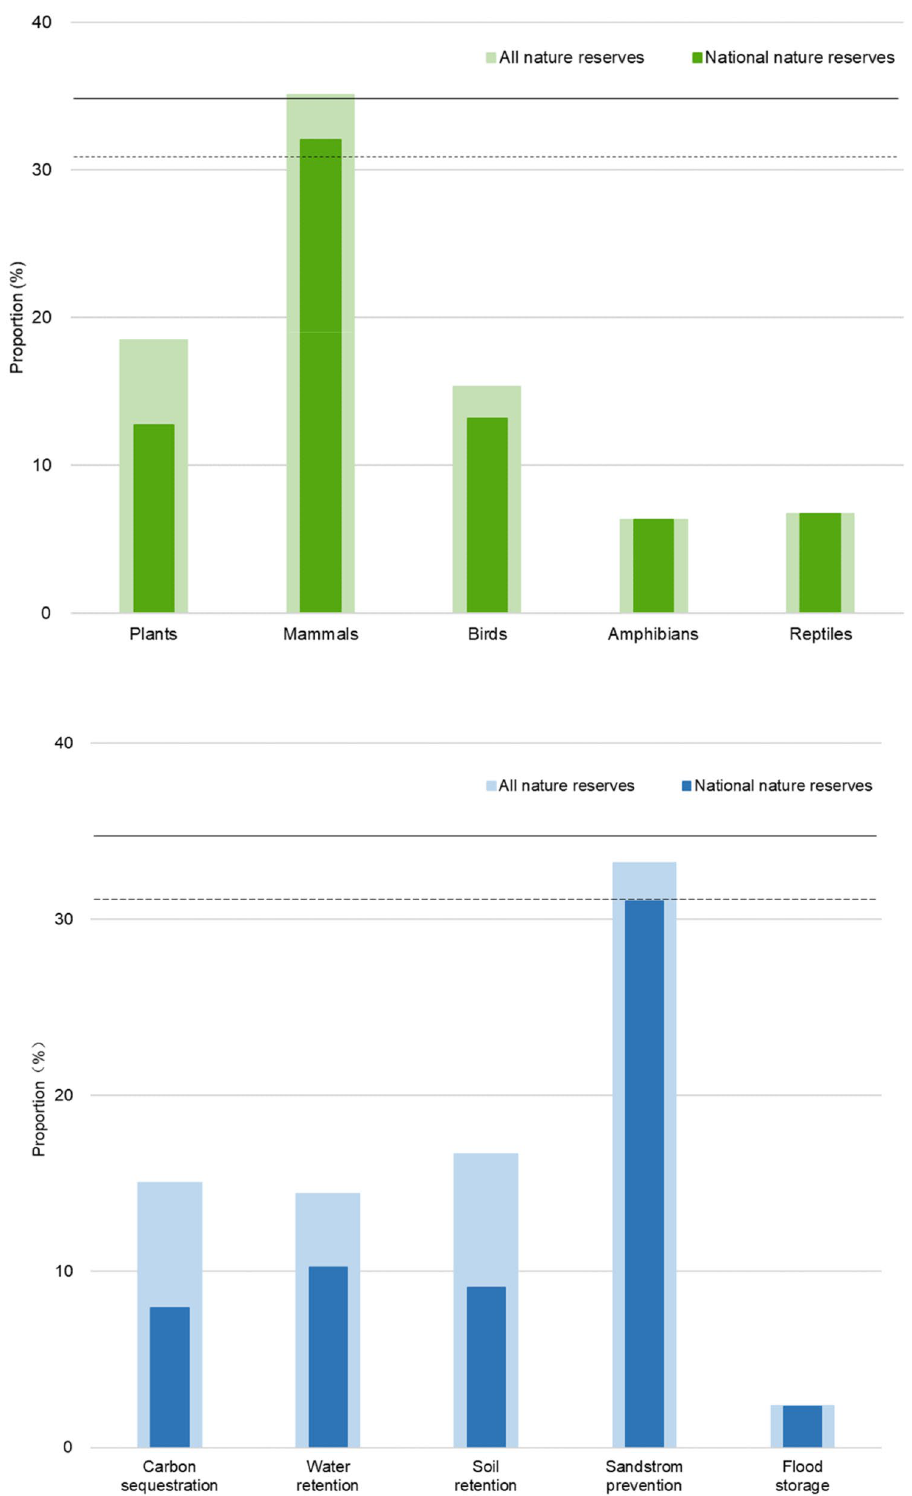
Figure 5. Biodiversity and ecosystem services conservation effectiveness map, solid line indicates the percentage of Tibet area taken up by all nature reserves, dashed line solid line indicated the percentage of Tibet area taken up by national nature